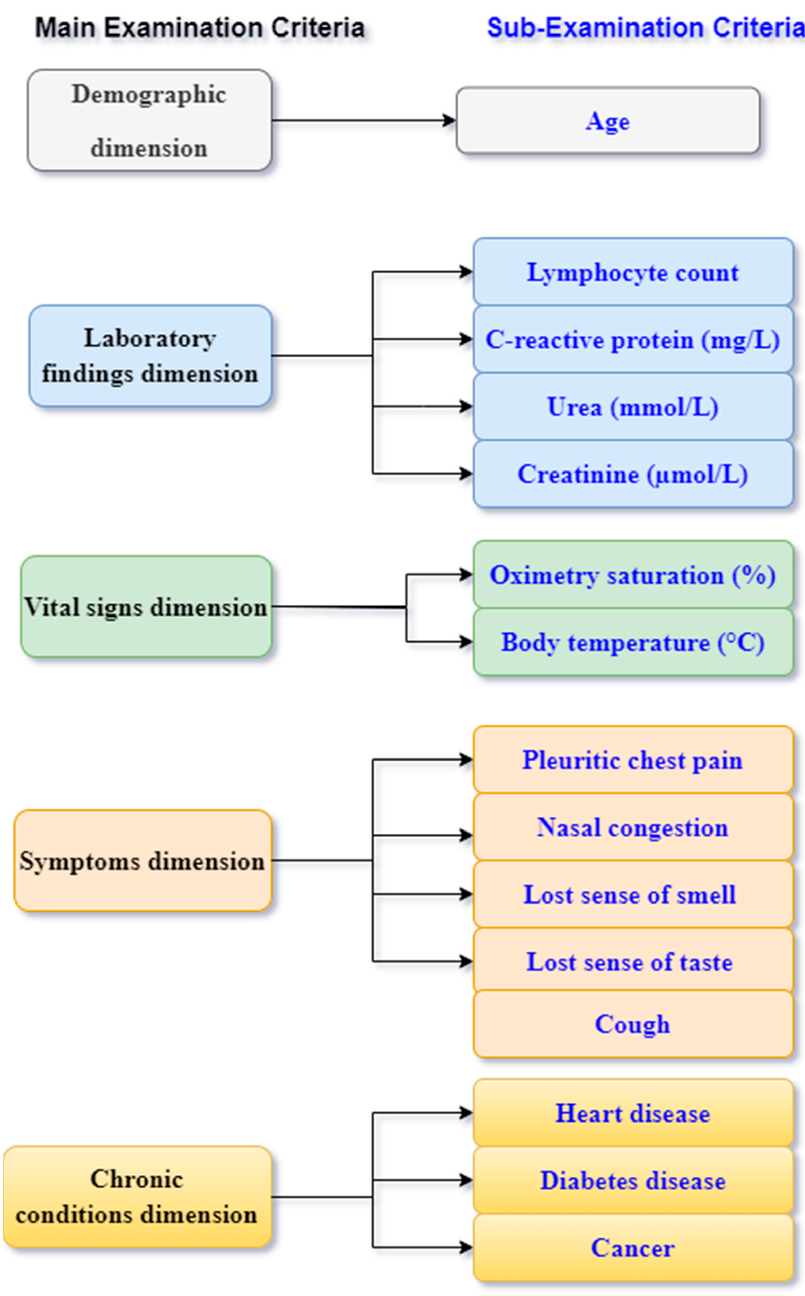
Figure 2. Main and sub-criteria for examination of COVID-19 patients.